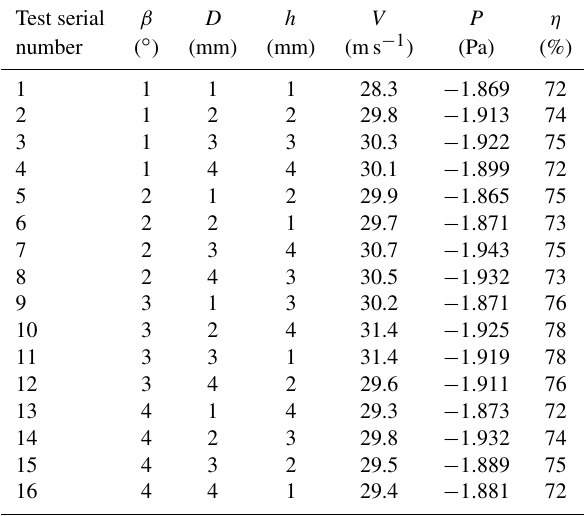
Table 3. Simulation